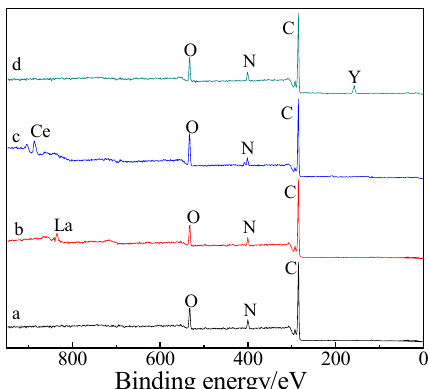
Figure 3. XPS spectra of the resin before ( a ) and after ( b ) La(III) or ( c ) Ce(III) or ( d ) Y(III) adsorption.